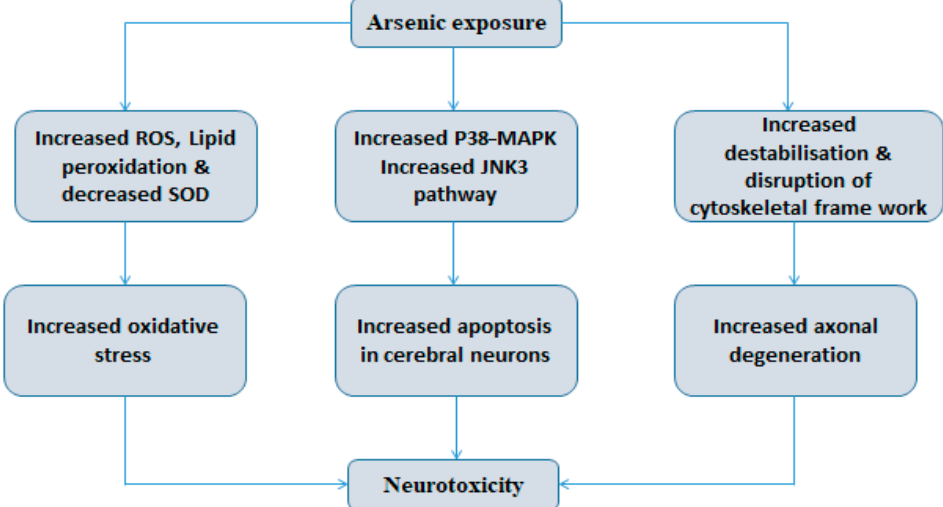
Figure 4. Three pathways of arsenic-induced neurotoxicity: (i) increase in ROS activity, lipid peroxidase and decrease in SOD activity leading to increased oxidative stress causing neurotoxicity; (ii) increased P38-MAPK, JNK3 pathway leading to increased apoptosis in cerebral neurons causing neurotoxicity; (iii) Increased destabilization, disruption of cytoskeletal framework and axonal de- generation.